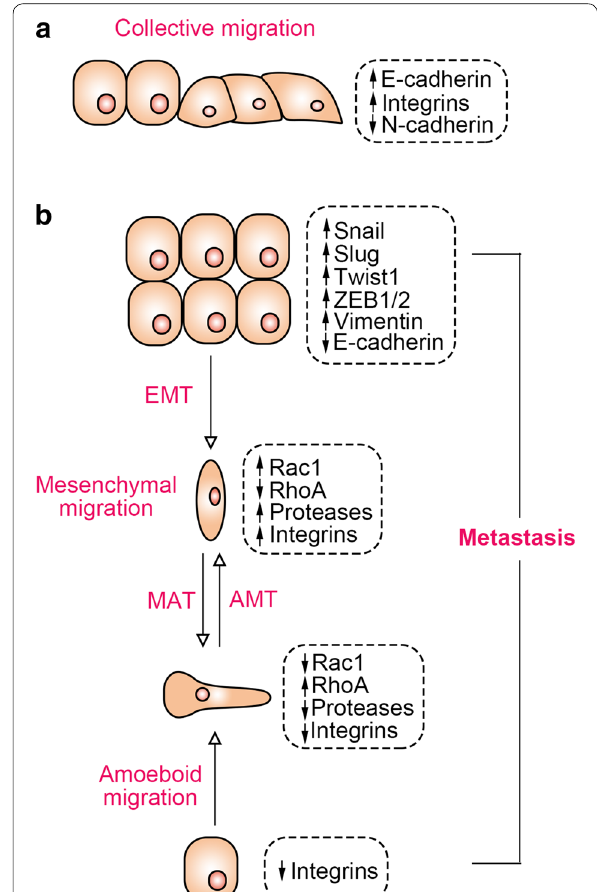
Fig. 1 Models and transitions of tumor cell metastasis. a Migration of whole groups of cancer cells; b migration of individual cancer cell. EMT epithelial-mesenchymal transition, MAT mesenchymal-amoeboid transition, AMT amoeboid-mesenchymal transition, ZEB1/2 zinc finger E-box-binding homeobox 1 and